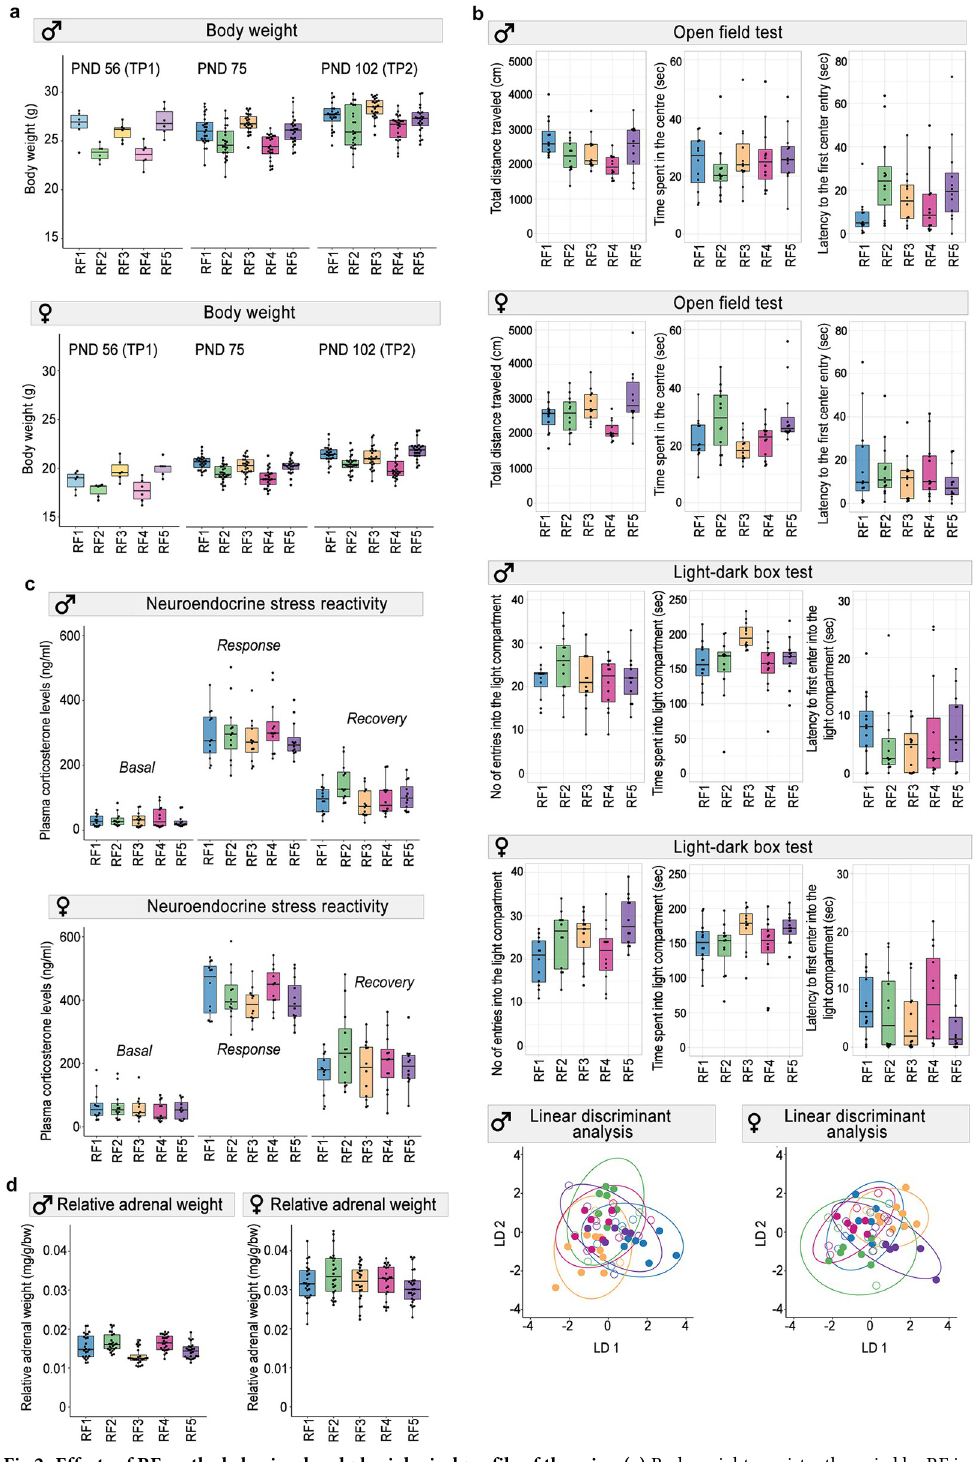
Fig 2. Effects of RF on the behavioral and physiological profile of the mice. (a) Body weight persistently varied by RF in both males and females ( n = 6 mice/sex/RF for TP1; n = 24 mice/sex/RF for TP2). ( b) Behavior of the mice varied consistently by RF both in males and females. In the LDA plots, color indicates RF, and the circles represent classification based on discriminant function analysis ( n = 12 mice/sex/RF). ( c) RF did not affect plasma corticosterone levels in the SRT both in males and females ( n = 12/mice/sex/RF), while relative adrenal gland weights ( n = 24/mice/sex/RF) were